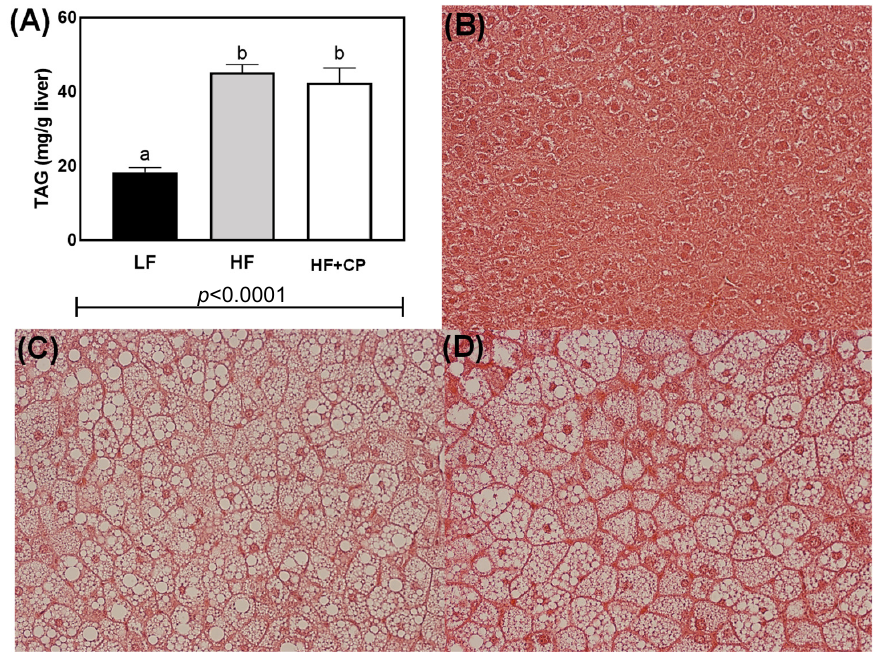
Figure 3. Total triacylglycerol (TAG) assay ( A ) and study hematoxylin-eosin stained liver cross sec- tions of male C57BL/6J mice fed a LF diet ( B ), a HF diet ( C ), or a HF+CP diet ( D ) for 10 weeks. Slides were observed under 400 magnification (40× objective) using an Olympus IX71 light microscope (Olympus America, Center Valley, PA, USA). One-way ANOVA indicated significant differences between diet groups ( p < 0.05). a,b Groups not sharing the same lowercase letters indicate that one- way ANOVA found significant differences between groups ( p < 0.05). Average ( n = 12 for control groups and n = 8 for experimental group) ± SEM.